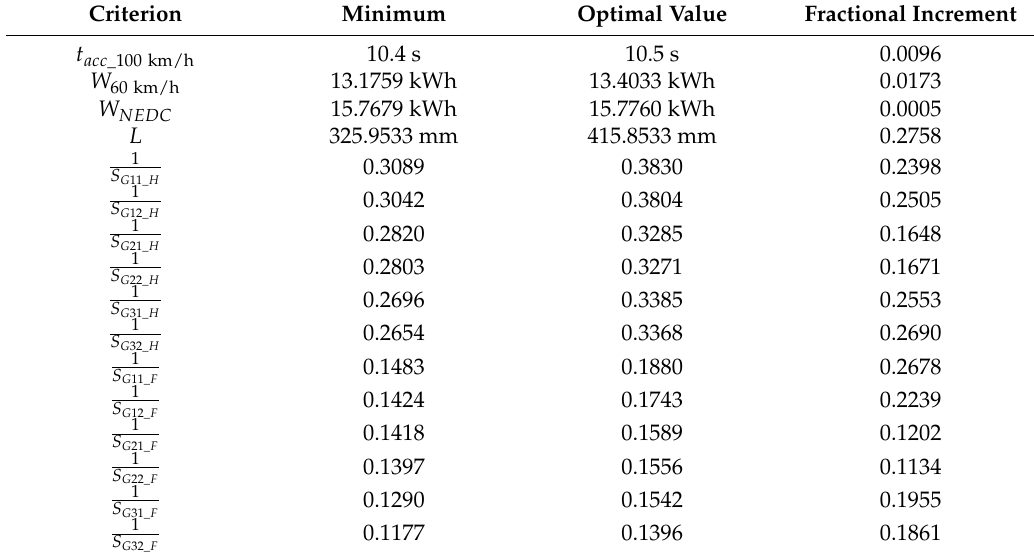
Table 4. Results of the gear train optimization problem (GTOP) of the two-speed dedicated electric transmission